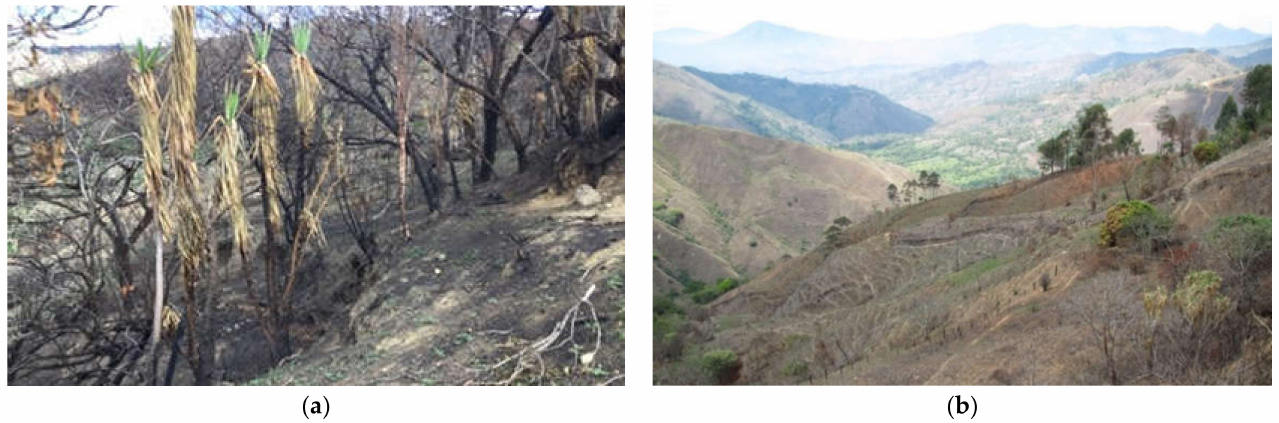
Figure 10. ( a ) Fire-affected shrub and tree vegetation layer ( b ) Impact of the wildfire on the landscape one month after the event in the canton Quilanga/Ecuador